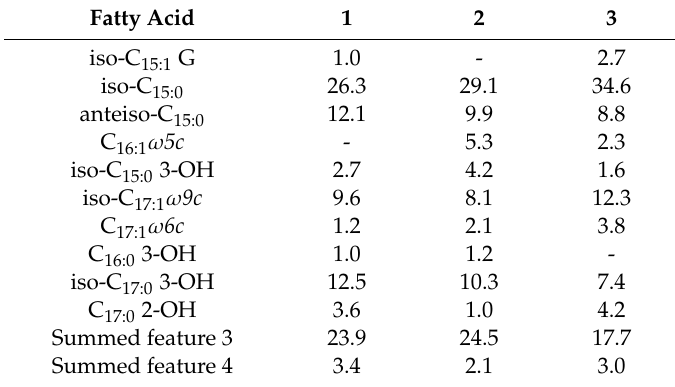
Table 5. Cellular fatty acid composition (%) of strain GBPx2 T and related species of the genus Cyclobacterium. Strains: 1, GBPx2 T ; 2, Cyclobacterium lianum IBRC-M 10422 T ; 3, Cyclobacterium jeungdonense IBRC-M 11102 T . All strains were grown under the same conditions (Marine agar